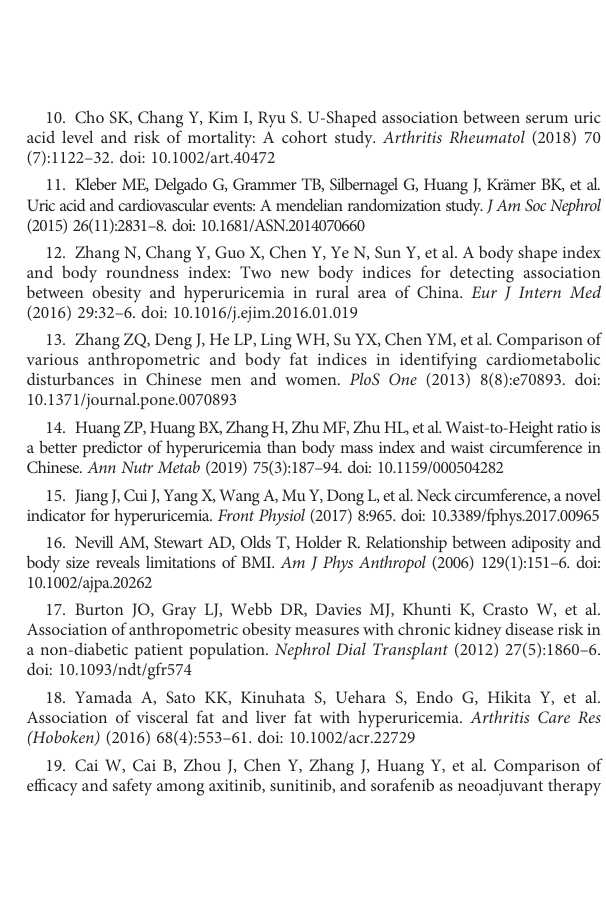
SUPPLEMENTARY FIGURE 3 ROC curves for incident hyperuricemia comparing VAI, BMI, and WC in male.